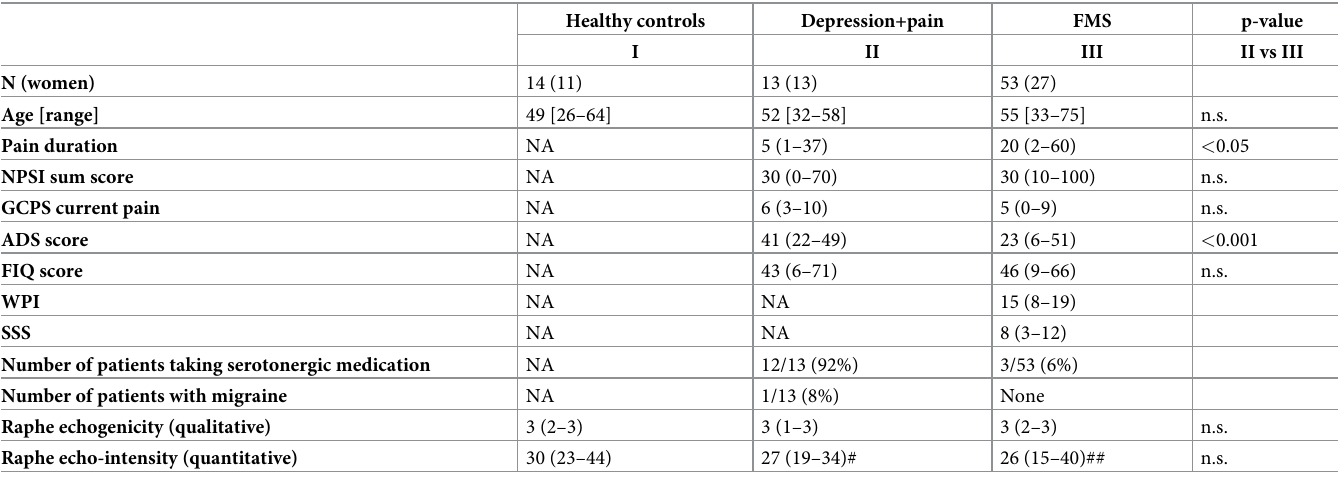
Table 1. Study subjects.